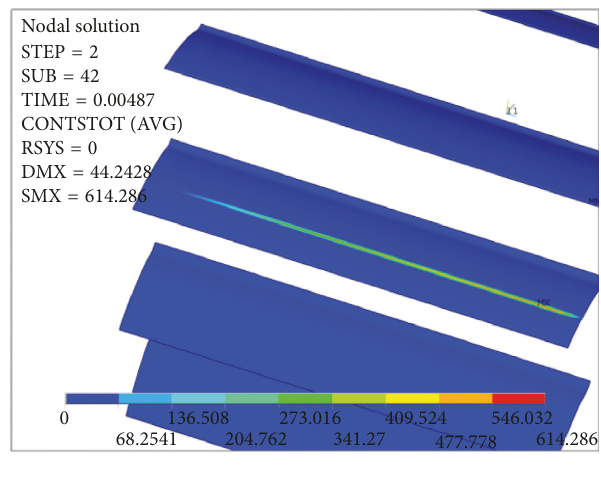
Figure 4: Contour map of contact stress.